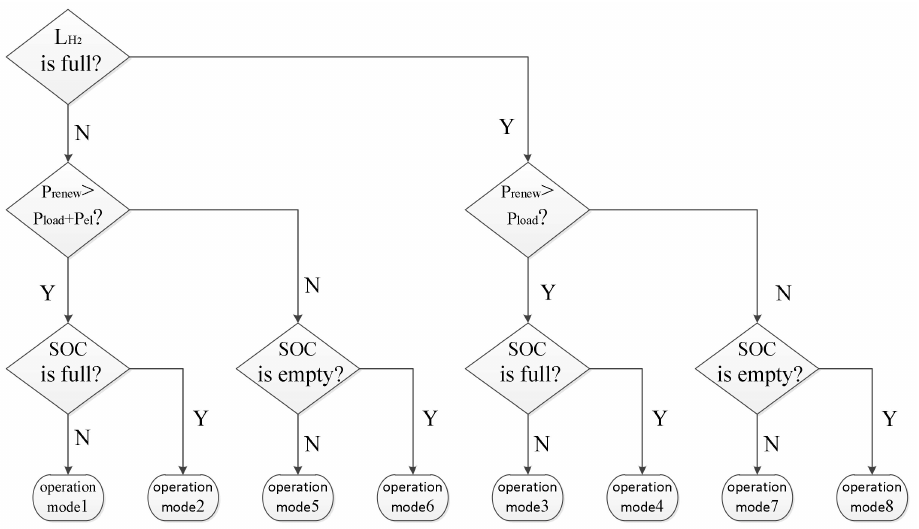
Figure 10. Operation strategy